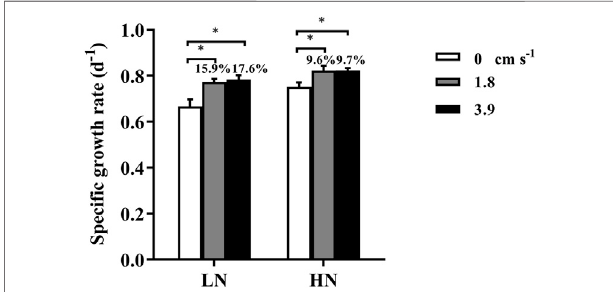
FIGURE 2 | The speci fi c growth rate (d − 1 ) of the diatom Thalassiosira weiss fl ogii grown within the dialysis bags (14 KD) under limited (10 μ mol L − 1 , LN) and replete nitrate (882 μ mol L − 1 , HN) and three water velocities (0, 1.8 and3.9 cm s − 1 )determinedover48 h.Dataarethemeans±SD, n =4(4 independent dialysis bags). Values above the bars indicate increased proportions of the speci fi c growth rate under water motion compared to that under motionless condition. One-way ANOVA and Tukey ’ s post-hoc test were employed to check the effects of water velocity on the speci fi c growth rates. Asterisk indicates the signi fi cant differences at p < 0.05